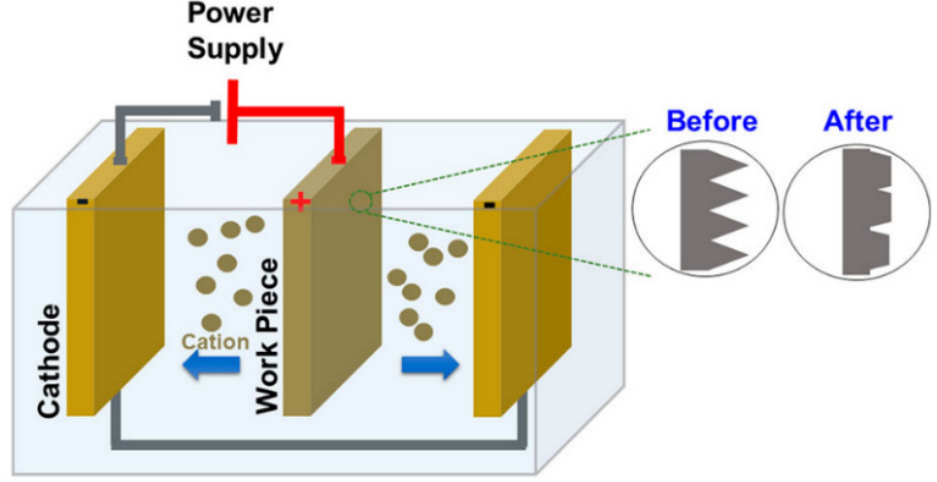
Figure 20. Schematic diagram of electropolishing setup [139]. Reprinted with permission from [139]; 2016 Taylor and Francis Group.